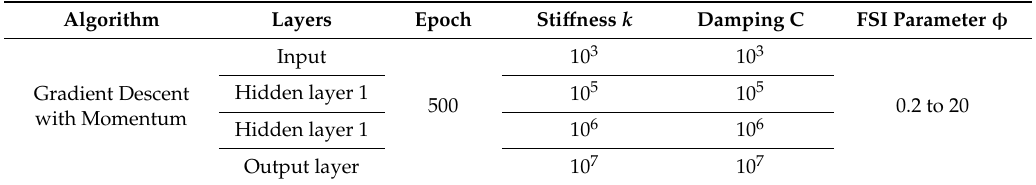
Table 1. BPNN and structure parameters for calculation.